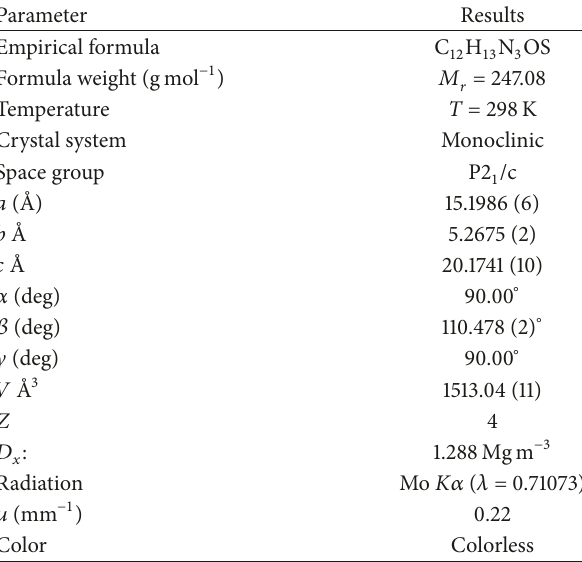
Figure 2: ESP maps (solid surface at left side and clipped surfaces at the right side showing atoms). The results should improve our knowledge aboutthebindingsites,whichareofimportanceinmedicalapplications.ColorcodebarsreflectelectrostaticpotentialenergyvaluesinkJ/mol. The redder the area is, the higher the electron density is susceptible to nucleophilic attack and the bluer the area is, the lower the electron density is that could easily binds with an electrophile. Table 1: Crystal experimental data for compound 3b